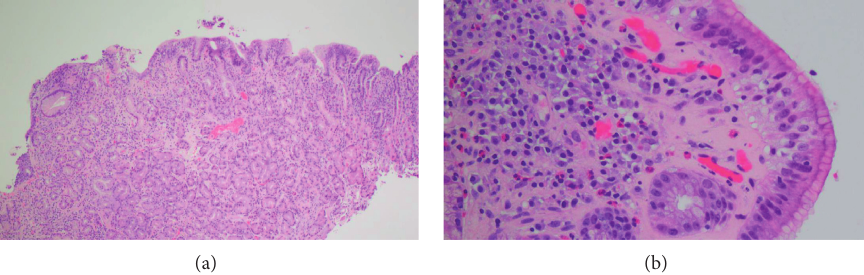
Figure 1: (a) 4x magnification of the results of upper endoscopy biopsy showing nonspecific chronic inflammatory infiltrate with a thickened subepithelial collagen table. (b) 20x magnification higher-power image of the thickened subepithelial collagen table, showing diagnostic features of entrapped cellular elements such as inflammatory cells and blood vessels.